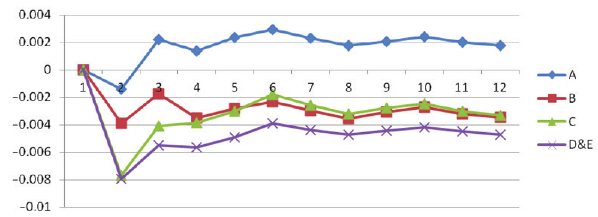
Figure 8c. Accumulated impulse response of PPI to shocks in stock market risk